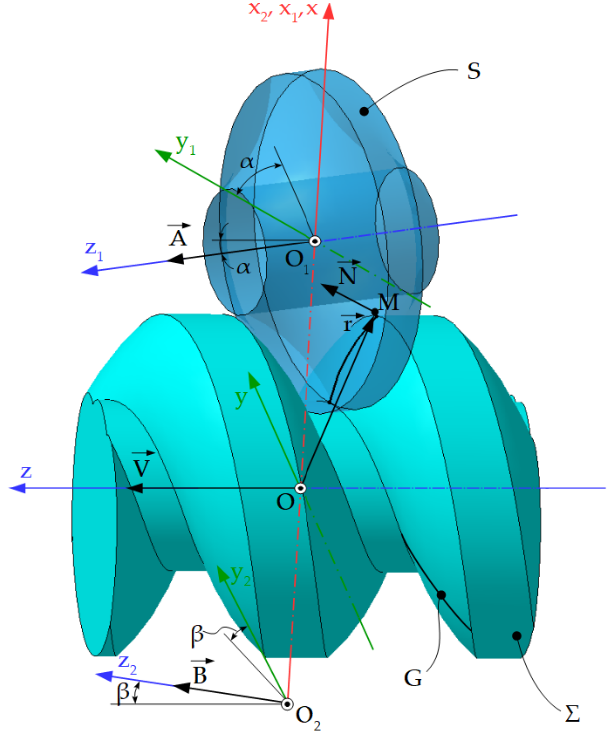
Figure 21. Generating with disc-tool.